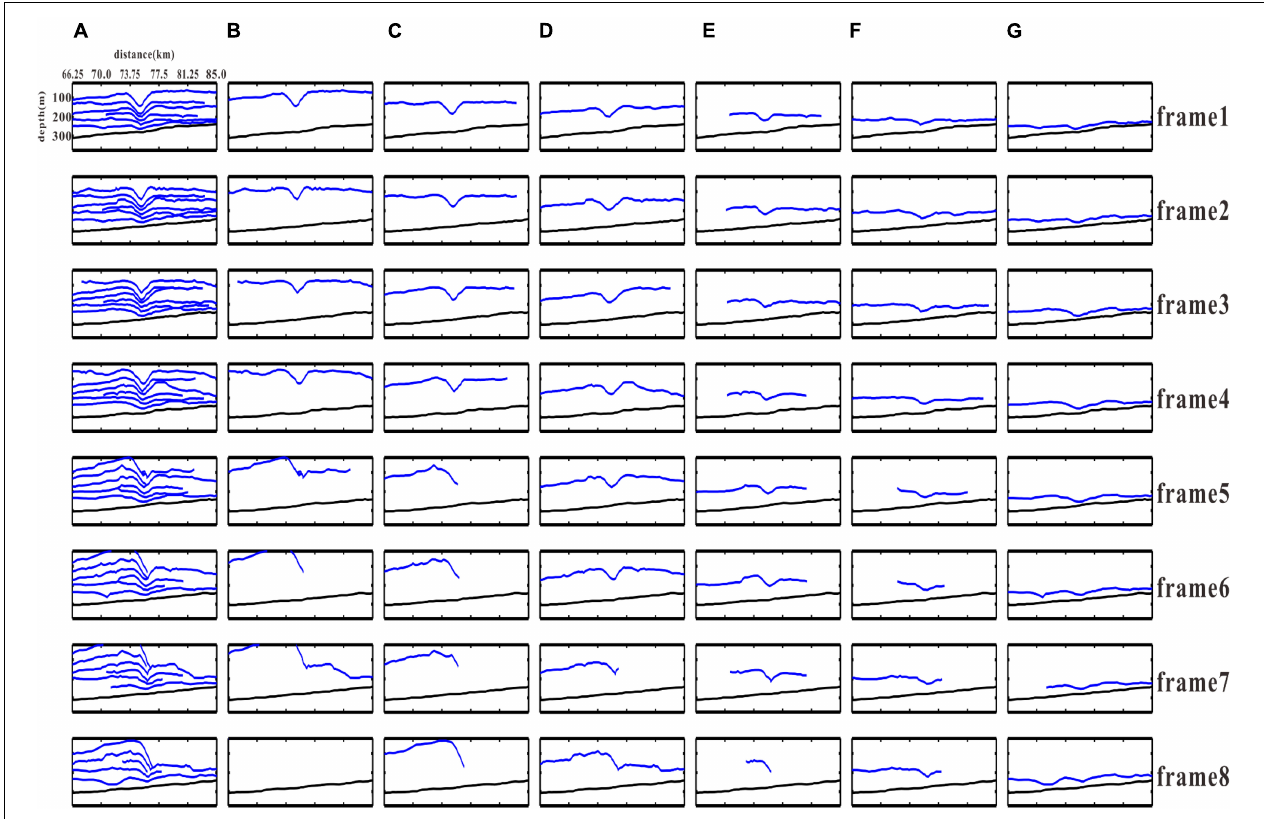
FIGURE 6 | Events (blue lines) picked from COG migrated sections showing the shape change of waveform. (A) Full six waveforms at different depths. (B–G) Separate display of the first to sixth